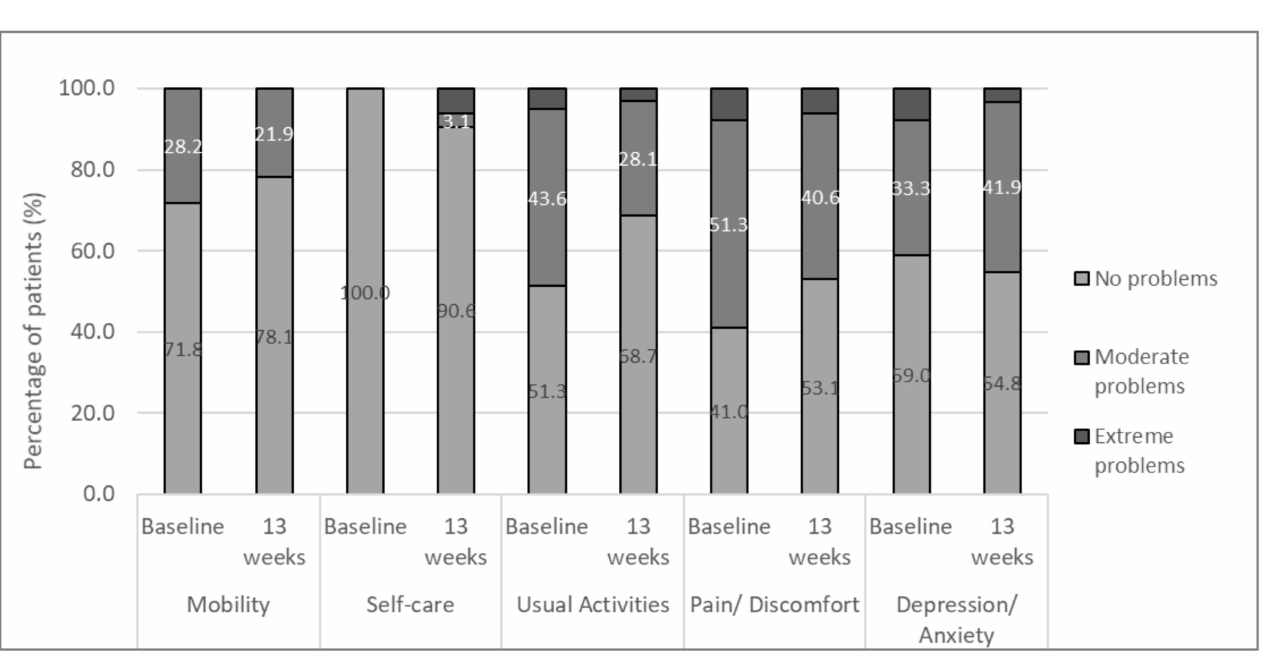
Figure 3. Distribution of responses on the EuroQoL